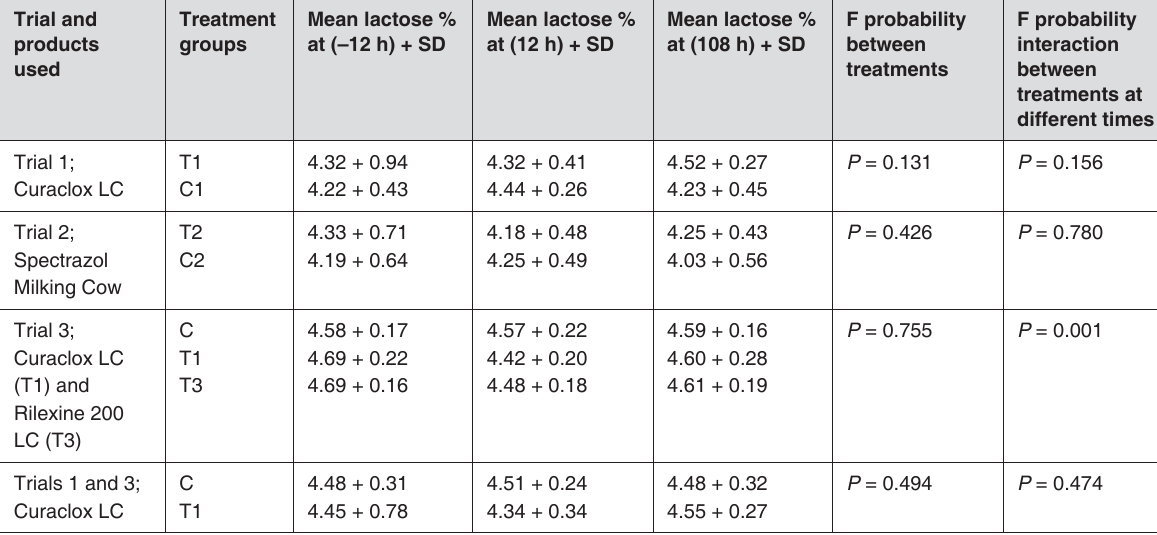
TABLE 5 Lactose percentages of milk for treatment (T1, T2 and T3) and control groups of goats. (Analysis of an unbalanced design) Trial and